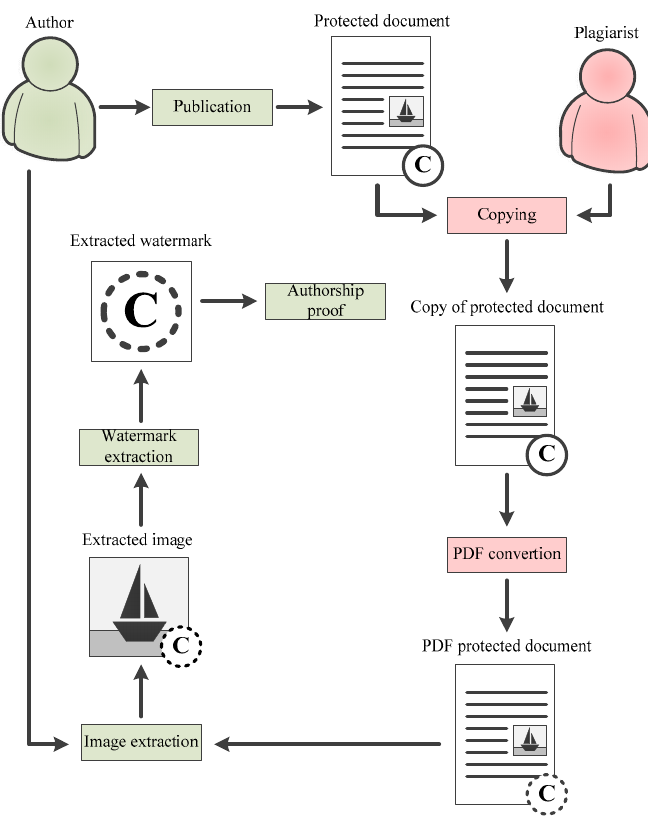
Figure 4. Authorship proof scenario when copying a full document.